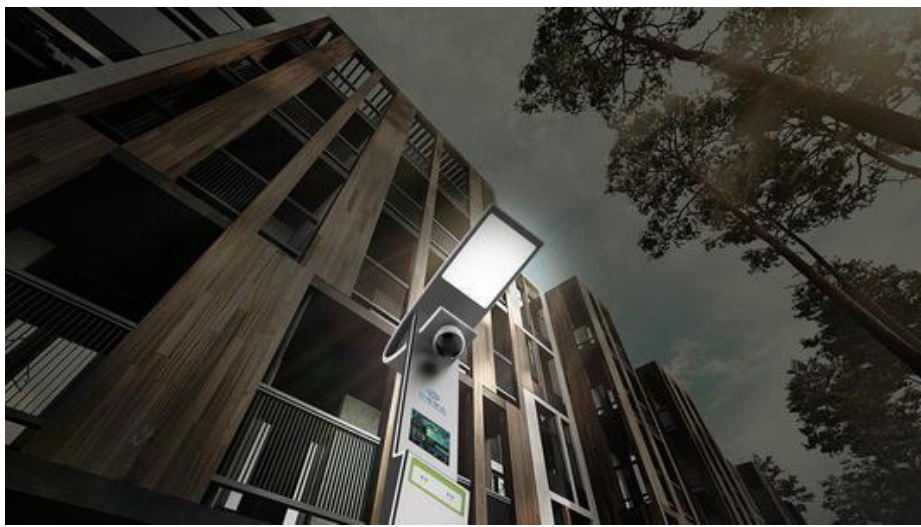
Figure 2 Night lighting of Smart streetlamps in Macau (Image source: Zhangshu Best